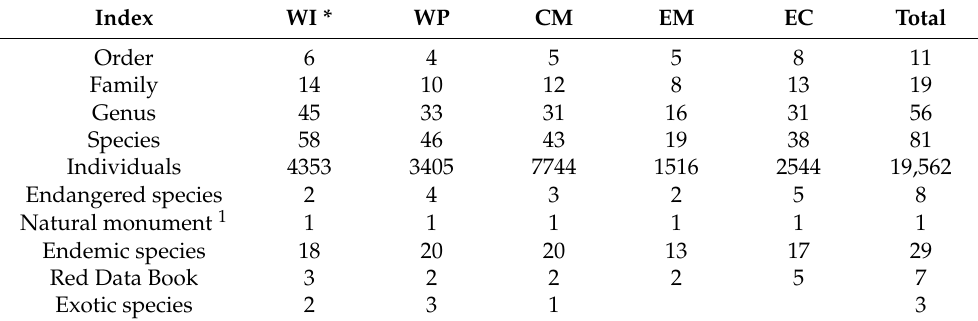
Table 1. Fish diversity and ichthyofauna were collected at each of the five survey regions, and in total, in the adjacent areas of the DMZ, Korea, from 2015 to 2019